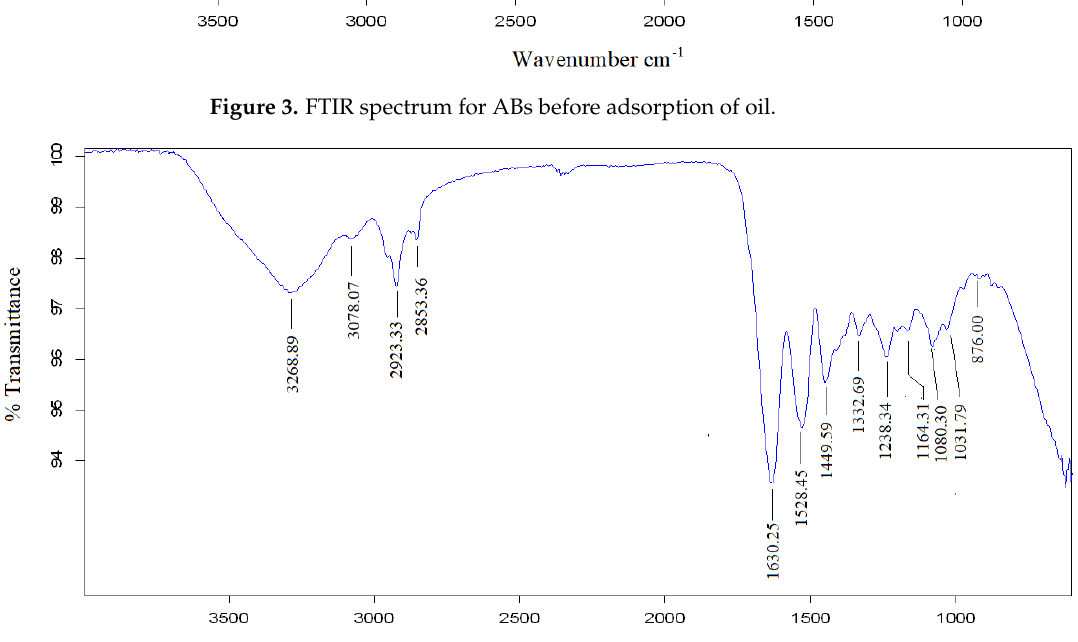
Figure 4. FTIR spectrum for ABs after adsorption of oil. Table 1. FTIR spectrum of AB adsorbents before and after the adsorption process of oil.